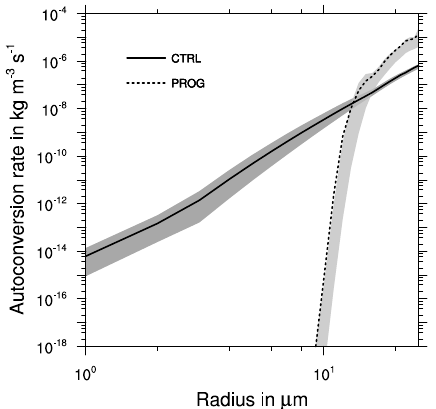
Figure 9. Dependence of autoconversion rate on effective cloud droplet radius for the month of July 2000. The lines denote the mean and the gray areas depict the range between the 10th and 90th per- centile,